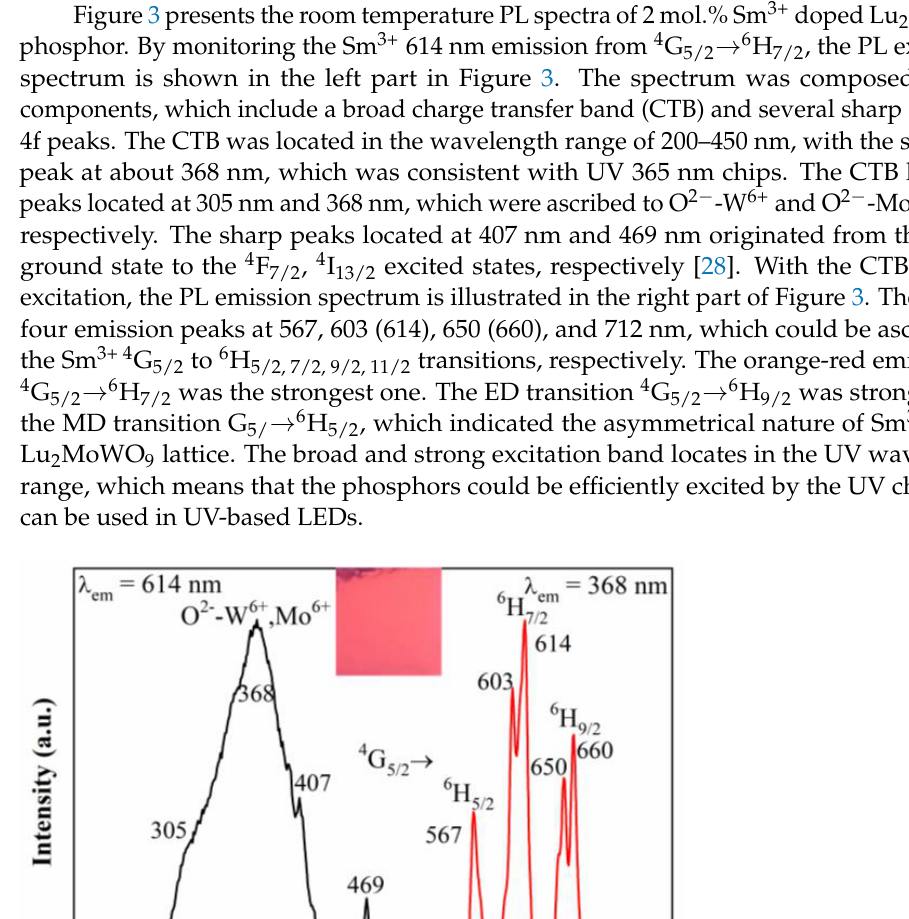
4 of 9 Figure 2. Field emission scanning electronic micrograph (FE-SEM) pictures of Sm 3+ doped Lu 2 Mo 0.5 W 0.5 O 6 ( a , b ), Lu 2 MoWO 9 ( c , d ), and Lu 2 (Mo 0.5 W 0.5 O 4 ) 3 ( e , f ).